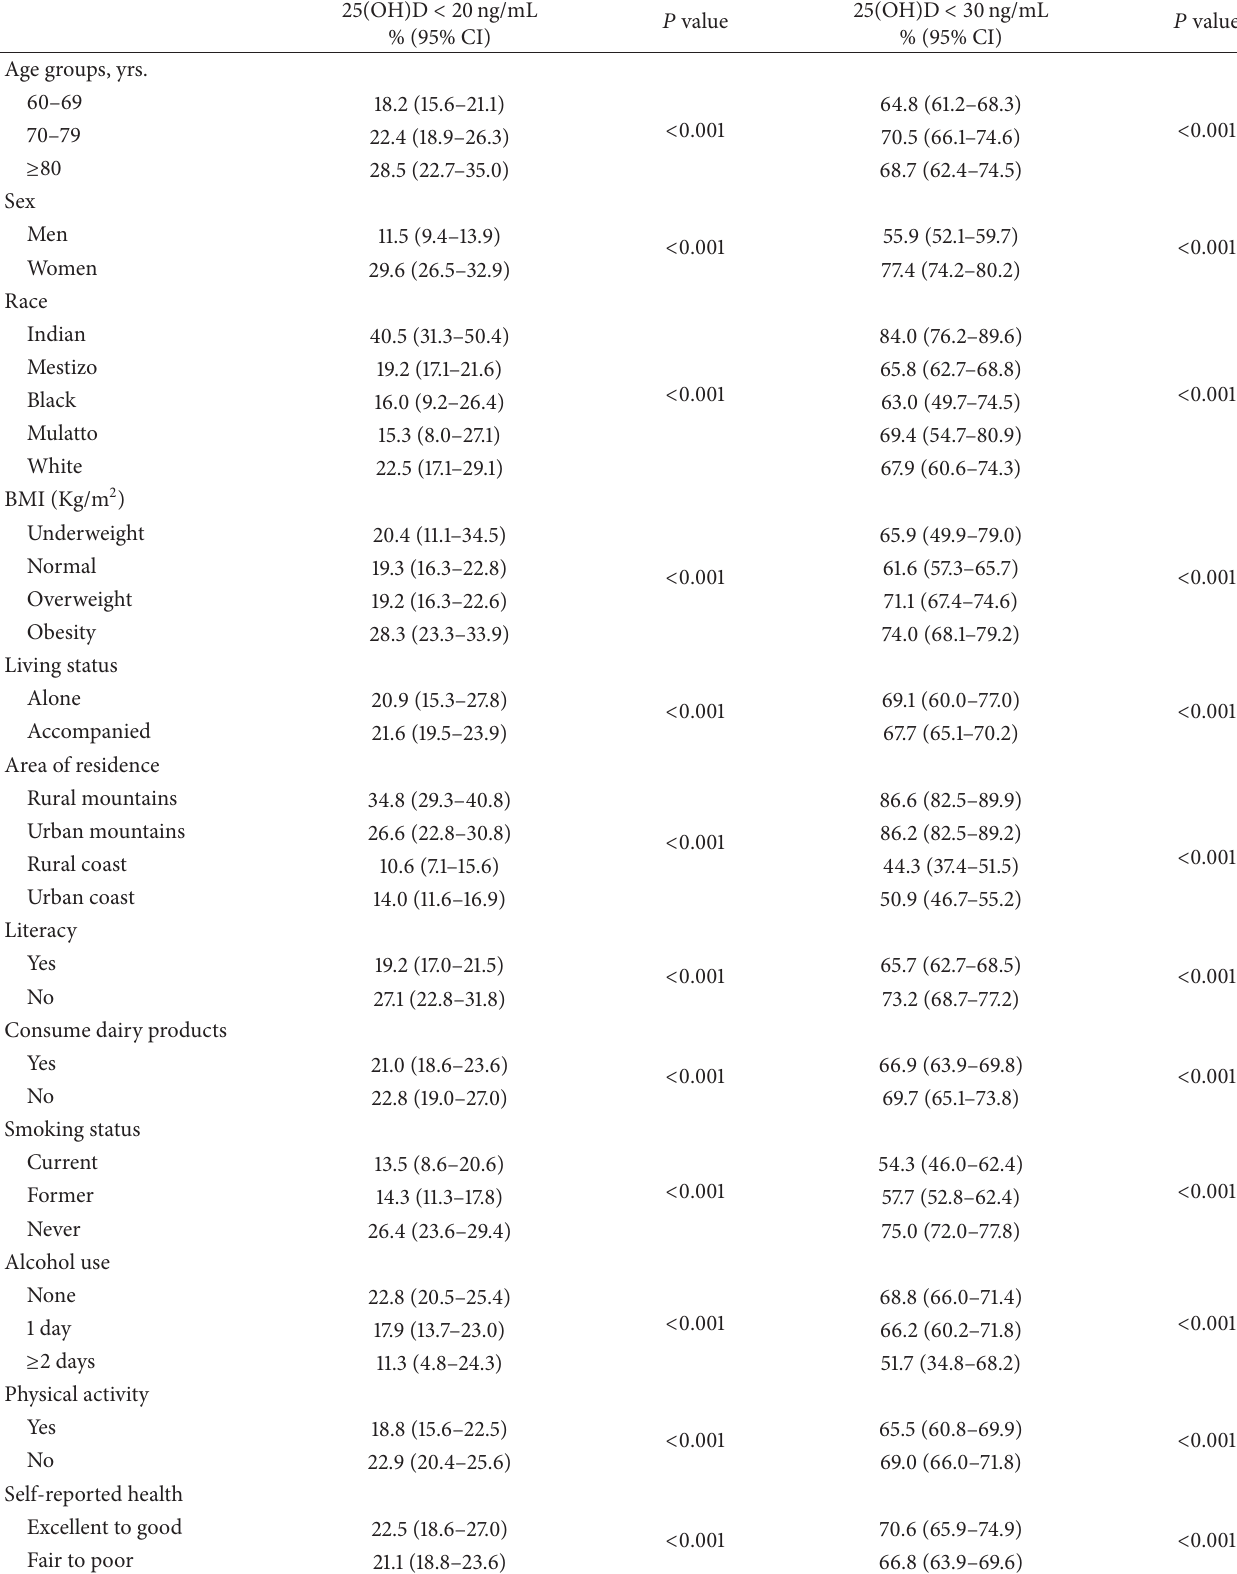
Table 2: Prevalence of 25(OH)D deficiency and insufficiency among older adults in